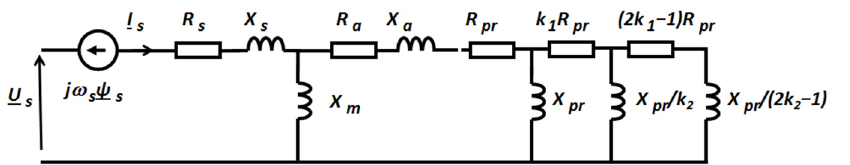
Figure 2. Equivalent circuit of a squirrel cage induction motor considering the phenomenon of current displacement in rotor bars [20]; R s , X s —resistance and leakage reactance of the stator winding, X m —magnetizing reactance, R a , X a —resistance and leakage reactance of the bar part in which there is no skin effect, R pr , X pr —resistance and leakage reactance of the bar part surrounded by a ferromagnetic core, in which the skin effect occurs (these parameters are determined during design calculations).